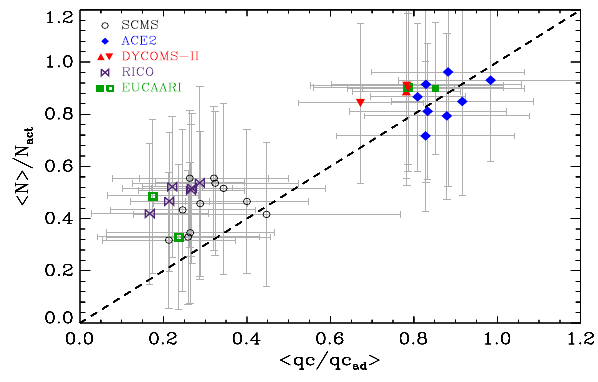
Fig. 8. Scatterplot of the CDNC adiabatic fraction as function of the LWC adiabatic